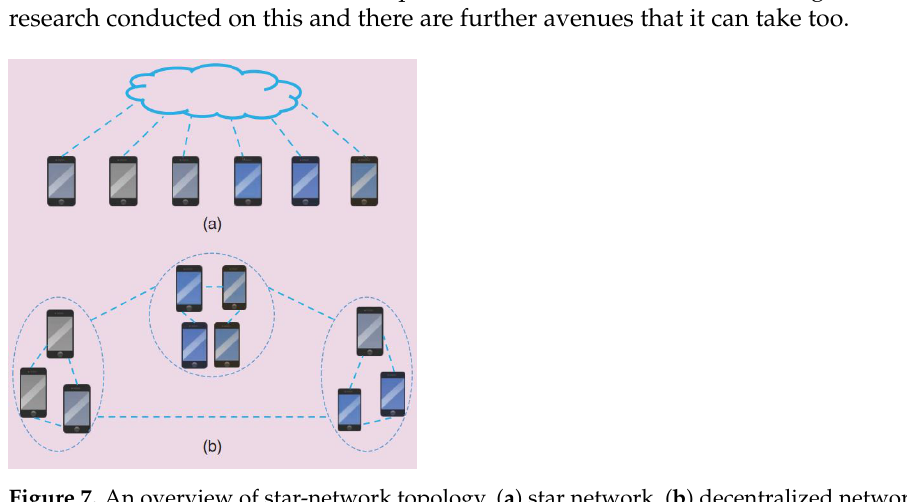
Figure 7. An overview of star-network topology. ( a ) star network, ( b ) decentralized network